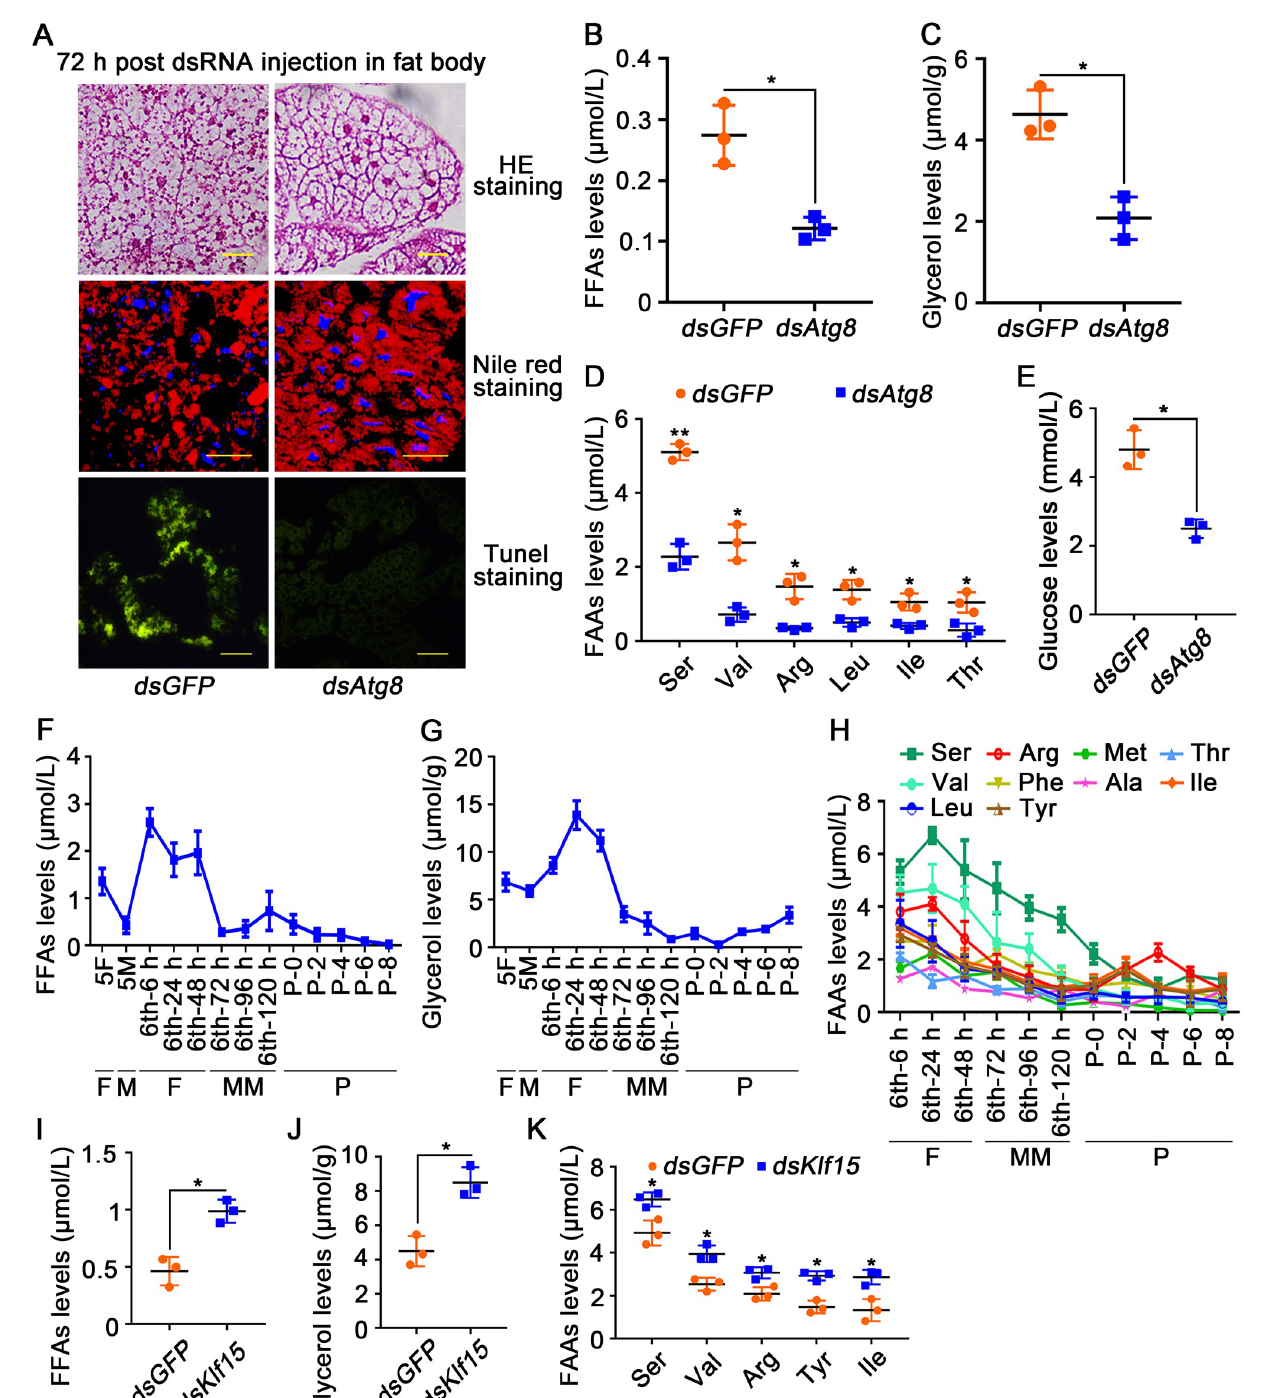
Fig 6. Autophagy presented substrates for gluconeogenesis. A. HE staining, Nile red staining and TUNEL staining showing the morphology of fat body after dsGFP and dsAtg8 injection into hemocoel. B and C. Levels of FFAs in the hemolymph and glycerol in the fat body after knockdown of Atg8 . D. FAAs levels in the hemolymph after knockdown of Atg8 . E. Glucose levels in the hemolymph decreased after knockdown Atg8 . F and G. FFAs levels in the hemolymph and glycerol levels in the fat body from 5th instar larvae to 8-day-old pupae. H. FAAs levels in the hemolymph. I and J. FFAs and glycerol levels after first injection dsKlf15 for 72 h. K. FAAs levels after knockdown of Klf15